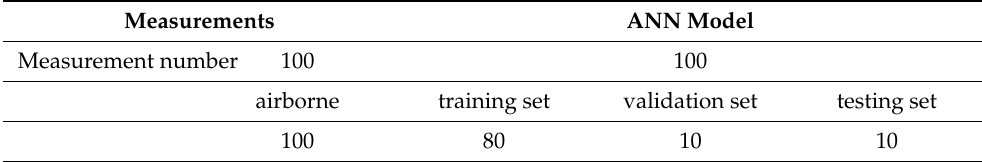
Figure 1. Standardized laboratory curves for airborne sound reduction index of façade walls. ( a ) Airborne sound reduction index values. ( b ) Mean and standard variation of airborne sound insulation curves. Table 1. A description summary of measurement numbers used by the prediction